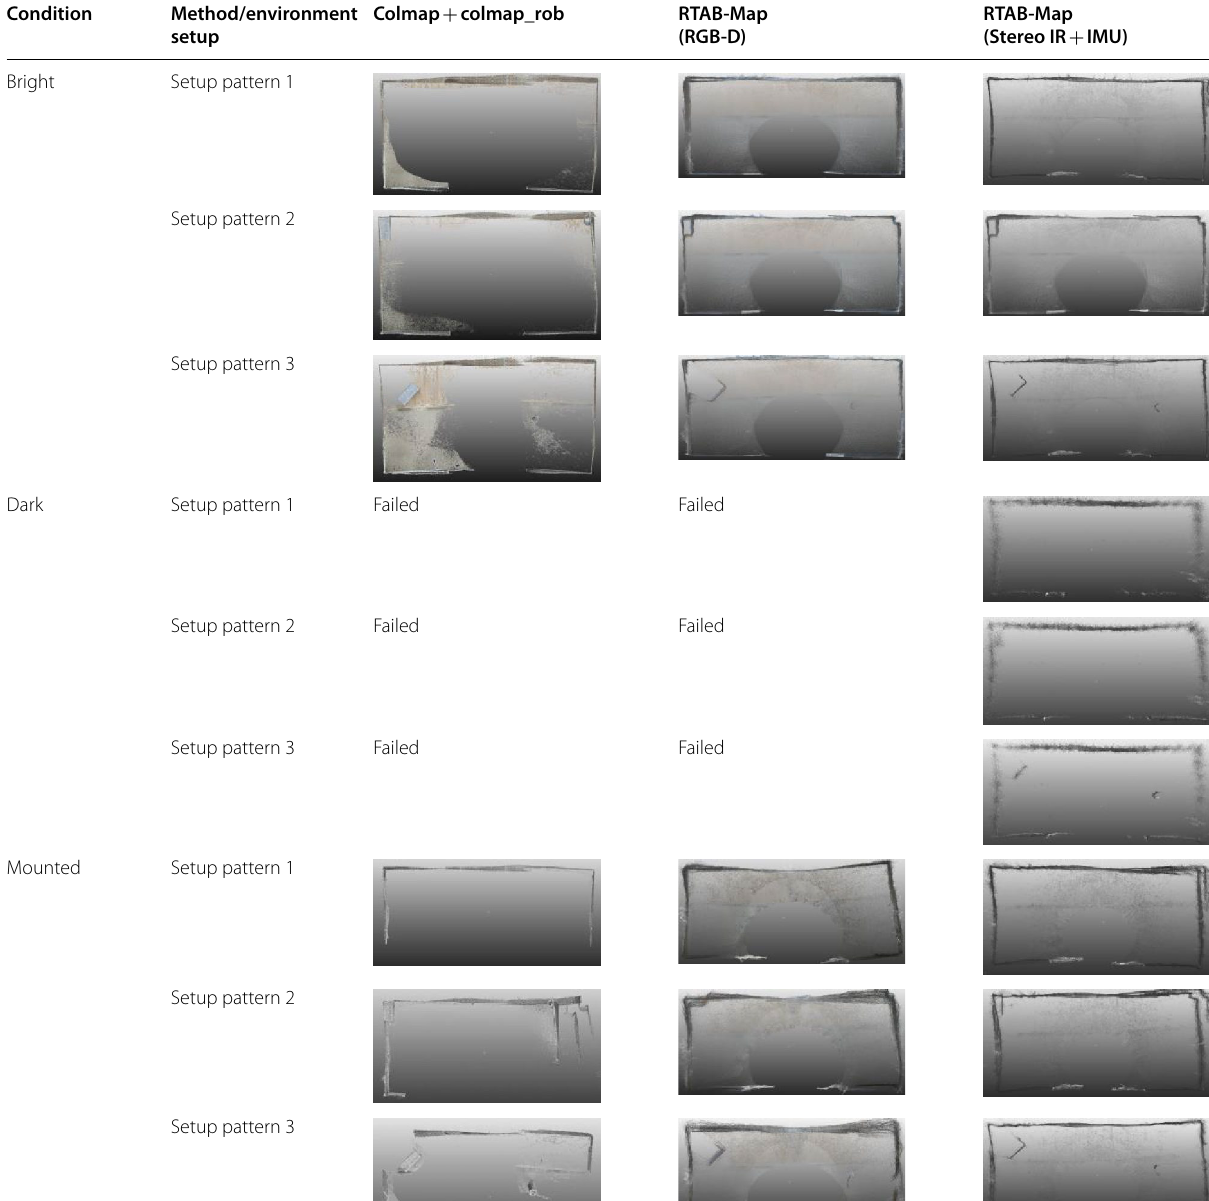
Table 11 Point clouds generated by three methods under different illumination conditions and environment setup patterns